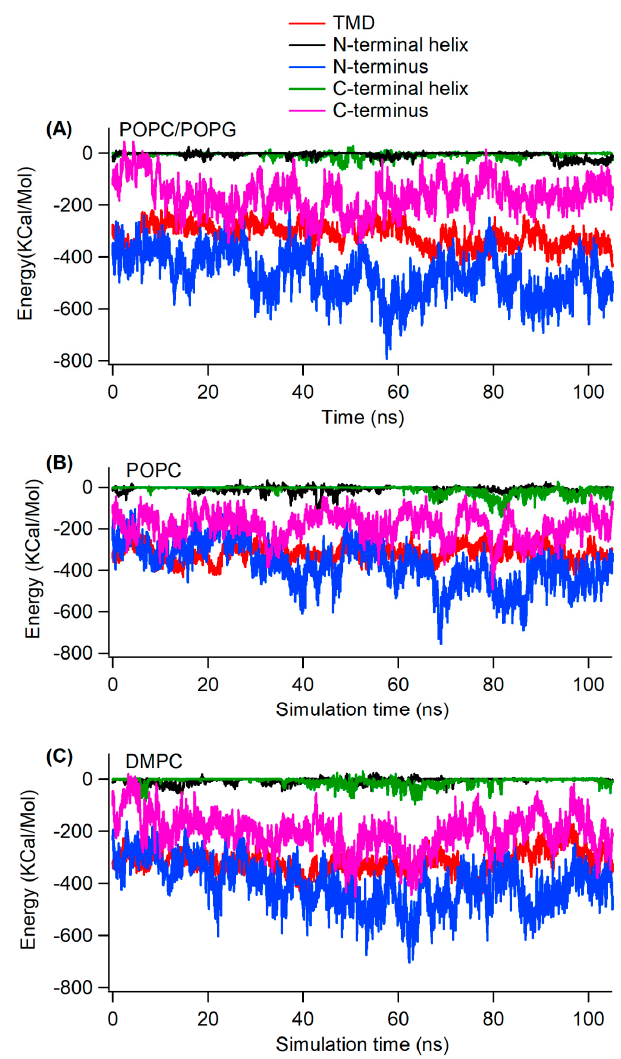
Figure 8. Interaction energy of different segments of KCNE3 with lipid bilayer membranes as a function of simulation time for POPC/POPG ( A ), POPC ( B ), and DMPC ( C ) lipid bilayers. These interaction energy data suggest that the N ‐ terminus interacts most strongly with the membrane surface but the interaction is dynamic and unstable, as the standard deviation in the average energy calculation is very high for this segment of the protein. While the interaction energy of TMD is higher than that of the N ‐ terminus, the stability of the TMD structure may be attributed to the internal energy of the protein its transient interactions with water molecules [16].